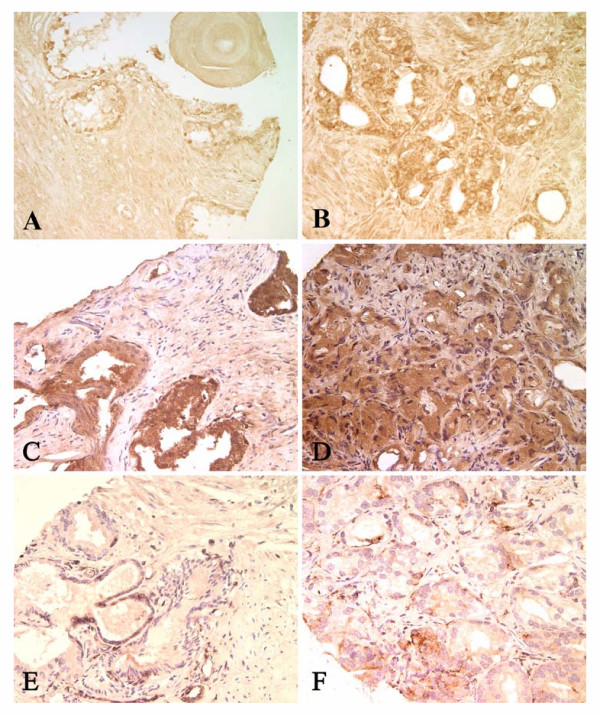
Matched prostatic tissue staining. All panels are 400 × total magnification. A) In situ hybridization – MIF in benign tissue B) In situ hybridization – MIF in matched cancer tissue C) Immunohistochemistry – MIF in benign tissue D) Immunohistochemistry – MIF in matched cancer tissue E) Immunohistochemistry – CD74 in benign tissue F) Immunohistochemistry – CD74 in matched cancer tissue